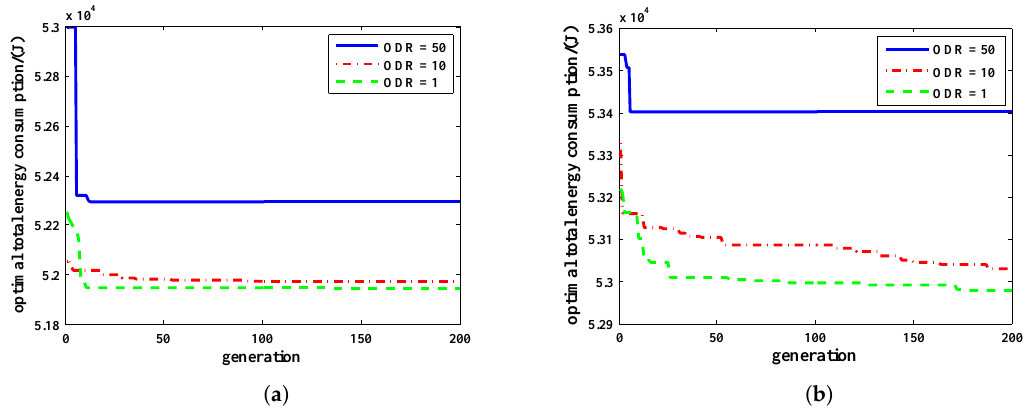
Figure 19. The optimal result of different ODR in the southern hemisphere. Panel ( a ) shows the optimal result in summer where the total energy consumption reduced by 13.5% and ( b ) shows the optimal result in winter where the total energy consumption reduced by